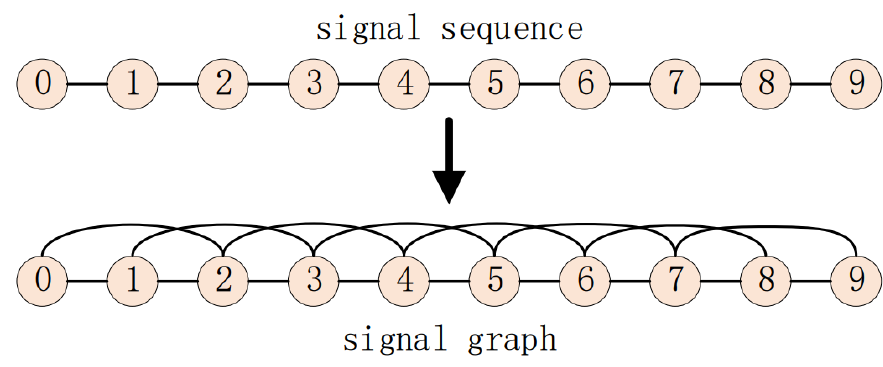
Figure 1. A signal graph constituted from a signal